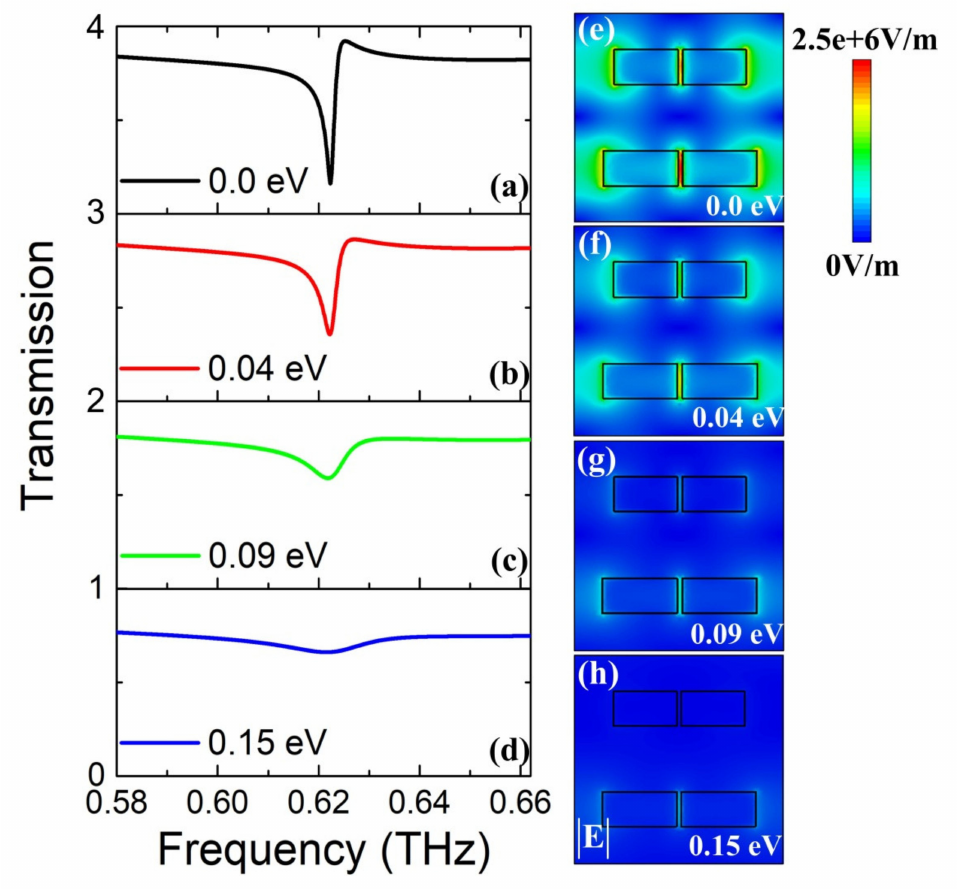
Figure 4. ( a – d ) Transmission spectra of the proposed metasurface structure by shifting the Fermi level of the graphene monolayer, where the temperature of STO is fixed as 300 K. ( e – h ) The corresponding electric field amplitude distributions at resonance frequencies shown in ( a – d ), respectively.